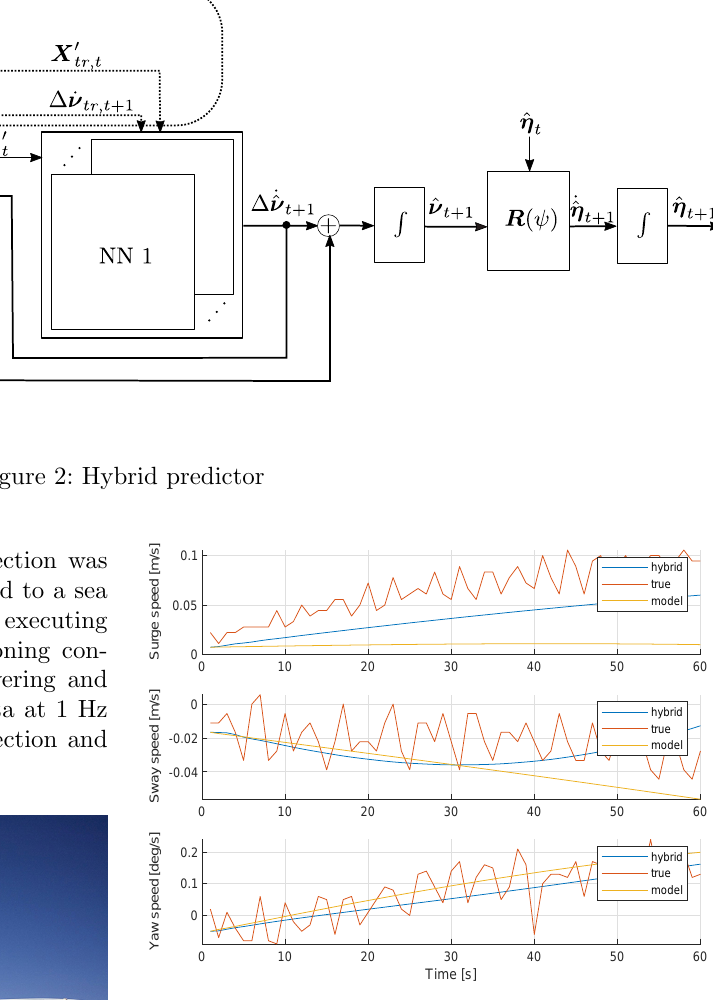
Figure 4: The velocities related to the first prediction interval starting from the point of